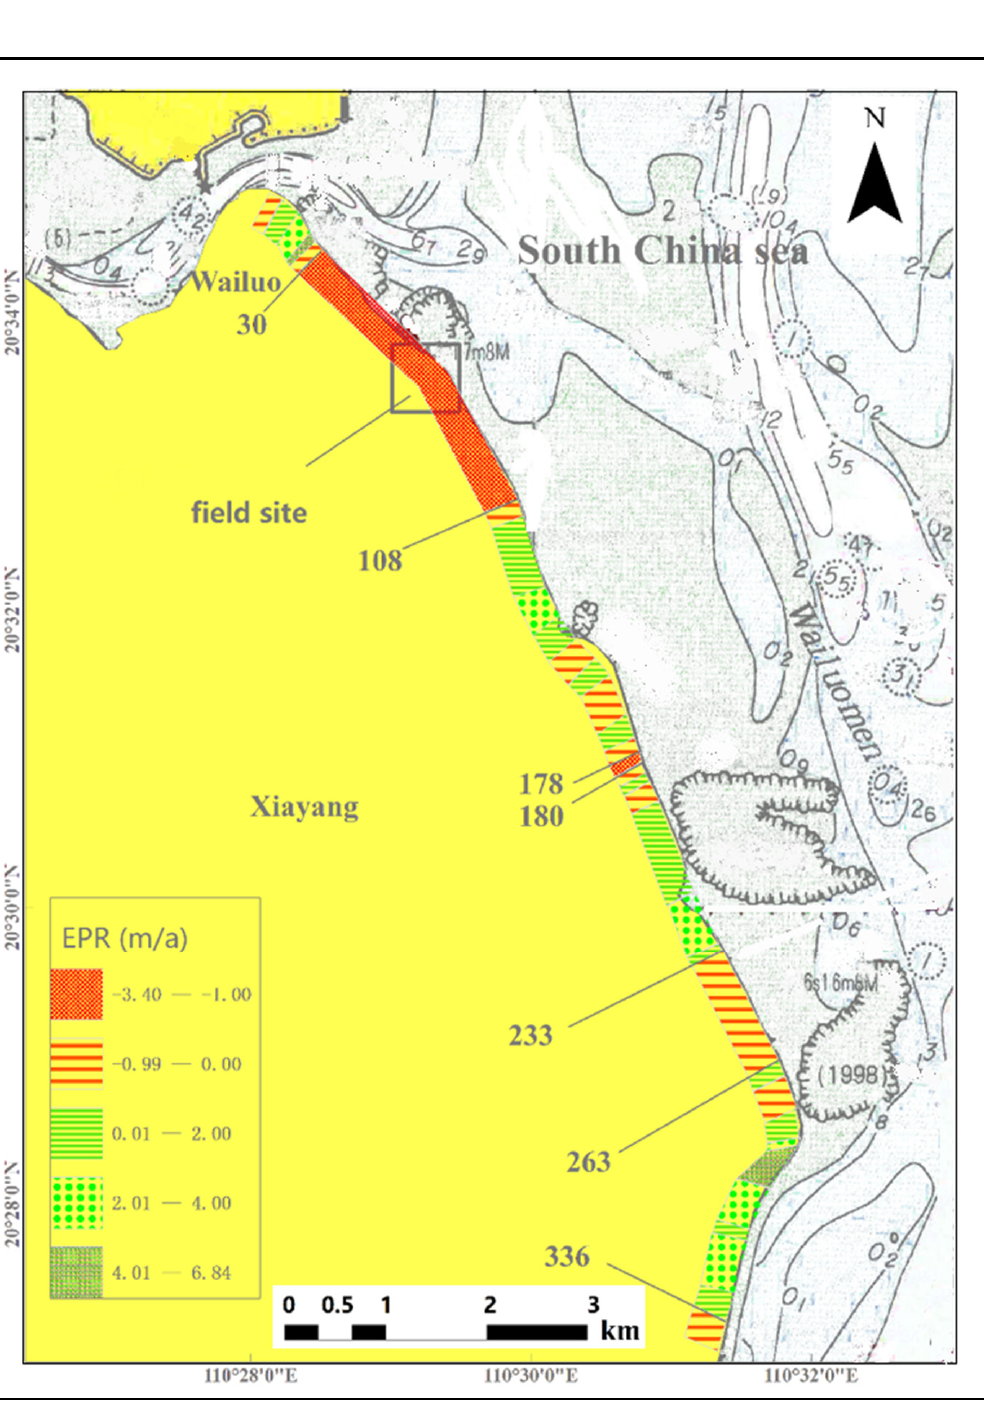
Figure 6. Spatial diagram of the EPR of transects in the study area.